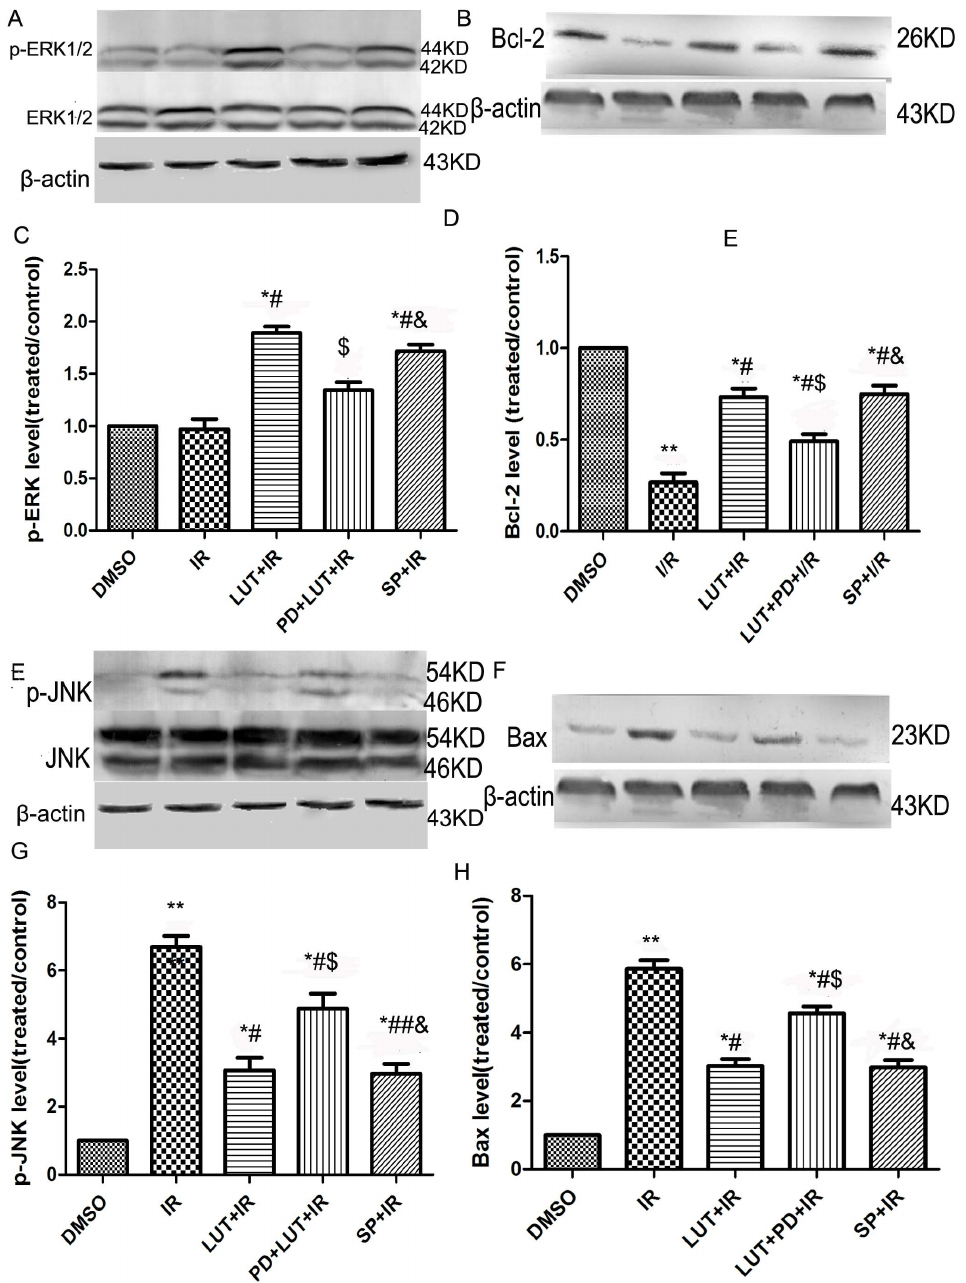
Figure 5. The expression of p-ERK1/2, p-JNK, Bcl-2 and Bax. The effects of luteolin and SP600125 on the expression of total ERK and p-ERK (A, B), Bcl-2 (C, D) total JNK and p-JNK (E, F), Bax (G, H). After 2 h reperfusion, the myocytes were harvested to detect protein expressions by western blot analysis. The results were expressed as the mean 6 SEM. n=3. ** P , 0.01 versus DMSO; # P , 0.05, ## P , 0.01 versus I/R; $ P , 0.05 versus I/R + Lut (8.0 m M), & P , 0.05, && P , 0.01 versus I/R + Lut(8.0 m M) + PD(10 m